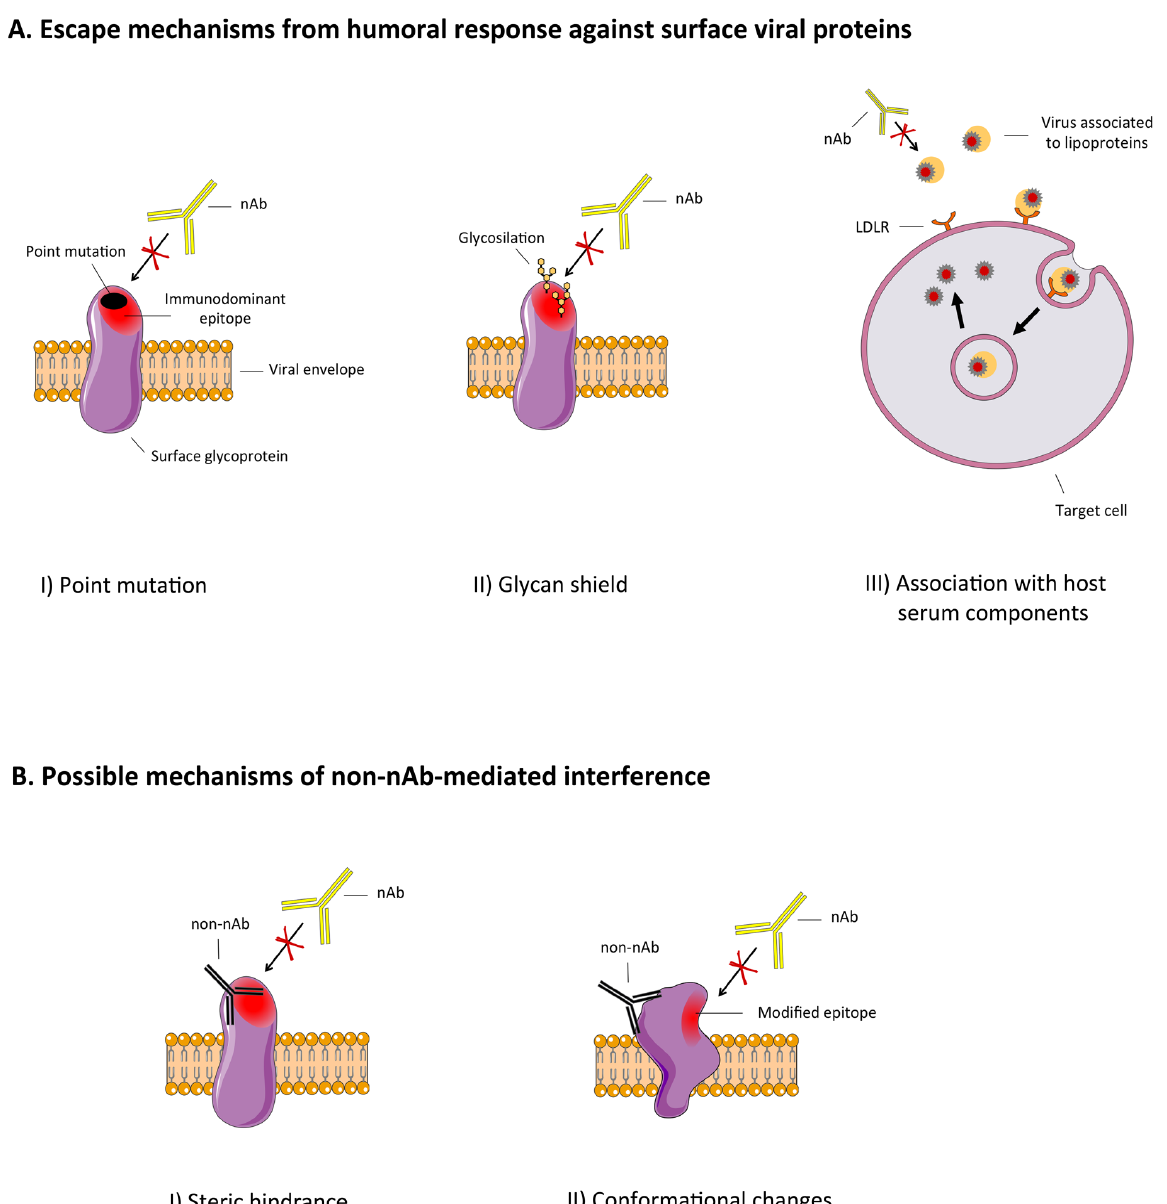
Figure 1. ( A ) Schematic representation of viral escape mechanisms from humoral immune response against surface viral proteins: point mutations on immunodominant regions, glycosylation of functionally pivotal residues (glycan shield) of the viral surface proteins and virus association with host serum components (e.g., lipoproteins) ( B ) Mechanisms of interference on nAb-mediated virus neutralization by the binding of interfering non-nAbs: non-neutralizing/interfering Abs might interfere with the binding of nAbs by steric hindrance following a spatial occupancy of their epitope or a competition for the binding; otherwise the binding of non-neutralizing/interfering Abs may induce conformational changes Non-neutralizing/interfering Abs are depicted in black while nAbs in